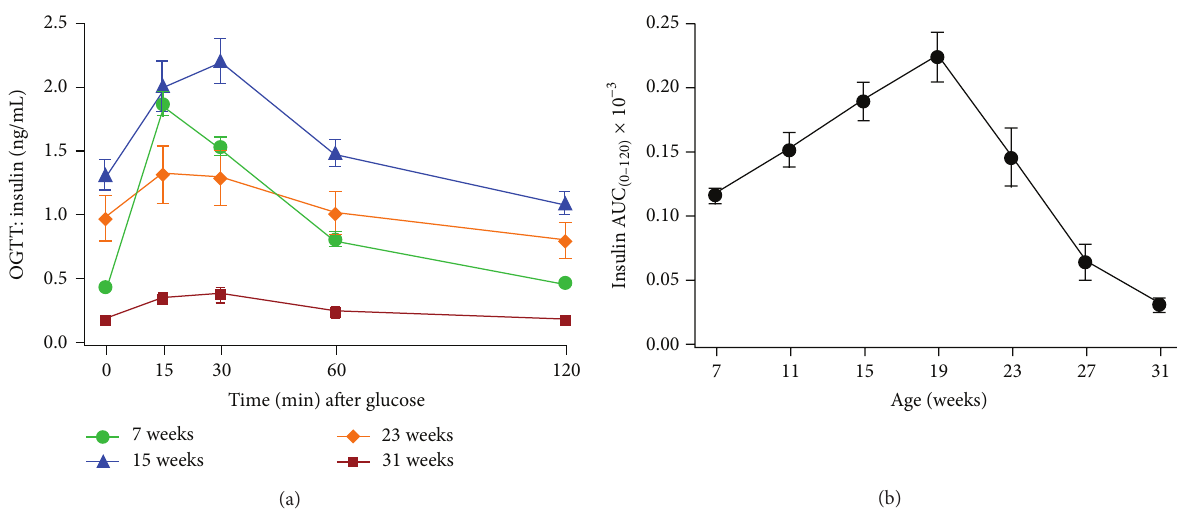
Figure 6: (a) Insulin levels from oral glucose tolerance tests in male ZDSD rats at 7 ( e ), 15 ( 󳵳 ), 23 ( X ), and 31 ( ◼ ) weeks of age and (b) insulin AUC for all OGTTs (mean ± SEM, 𝑛 = 23 ).